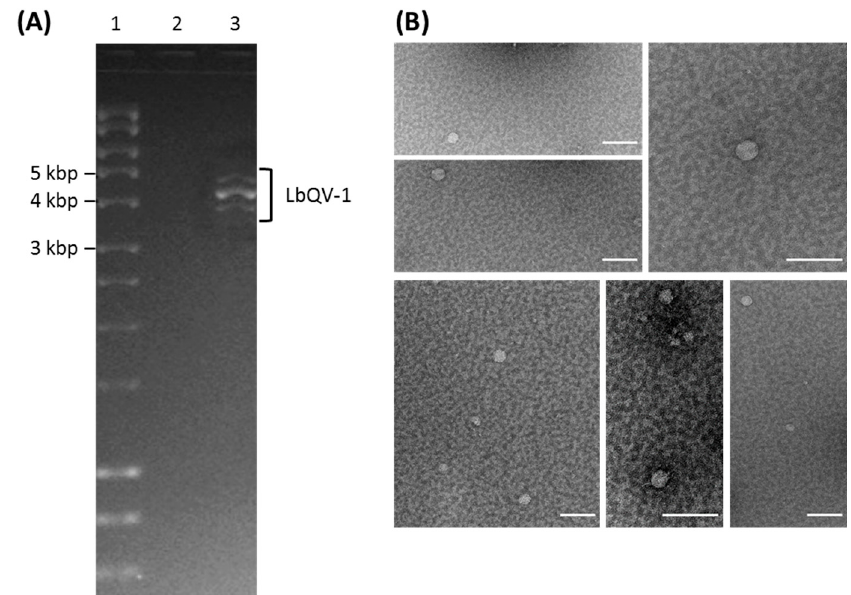
Figure 1. LbQV-1 particle morphology and dsRNA genome. ( A ) Agarose gel electrophoretic fractionation of the LbQV-1 genomic dsRNA segments. RNA was isolated from purified LbQV-1 preparations and the dsRNA profile of the virus-infected Chinese isolate W10 is shown in lane 3 while a dsRNA preparation from the same L. biglobosa isolate freed from virus infection and nominated strain W10-VF-1 is shown in lane 2. Lane 1 contains the DNA marker Hyperladder (Bioline), the sizes of which are shown to the left of the gel. ( B ) Electron micrograph of LbQV-1. Virus particles purified from Leptosphaeria biglobosa strain W10 were examined in the electron microscope after staining with uranyl acetate. Size bars indicate 100 nm.